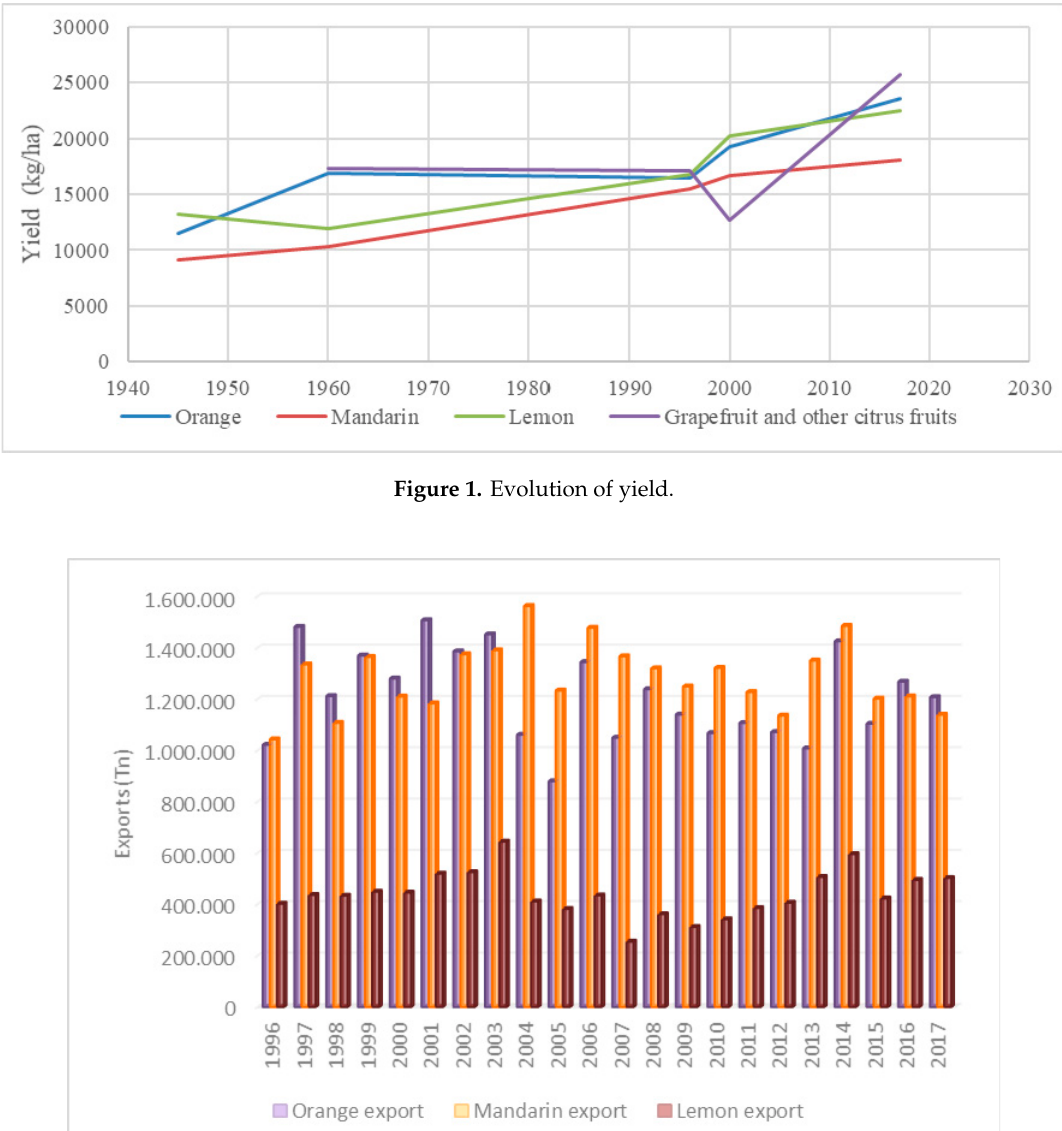
Figure 2. Progression of orange, mandarin, lemon exports.